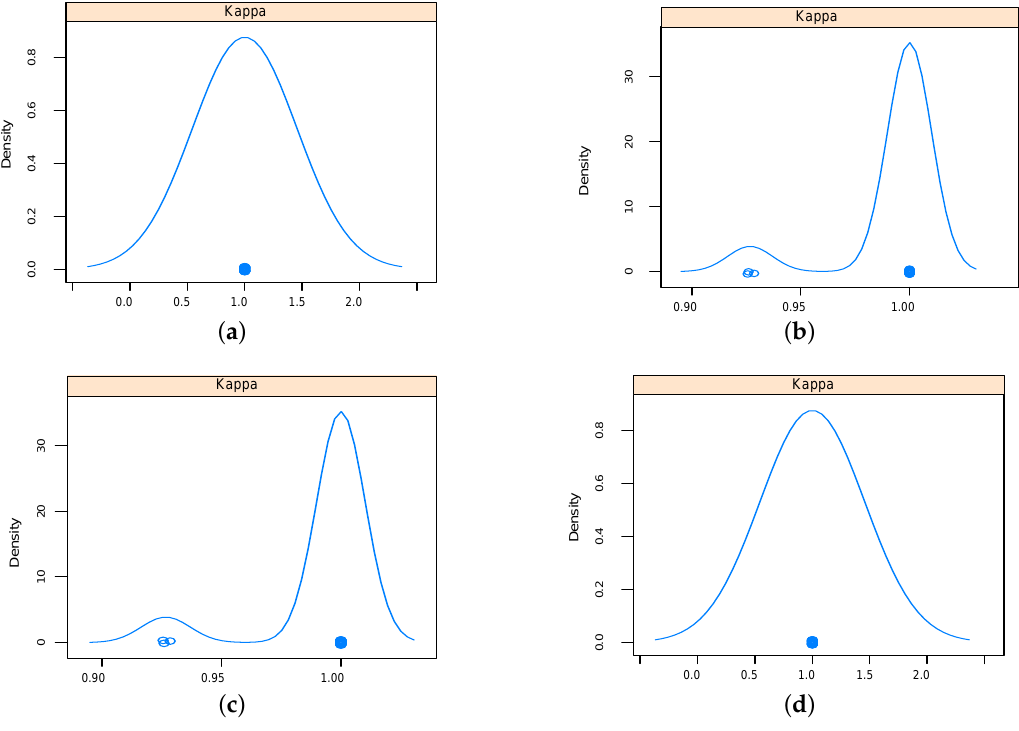
Figure 9. Kappa density plots for the implemented classifiers using five-dimensional data set using relief feature selection. ( a ) K-nearest neighbor (KNN); ( b ) Random Forest (RF); ( c ) Neural networks (NN); ( d ) Support Vector Machine